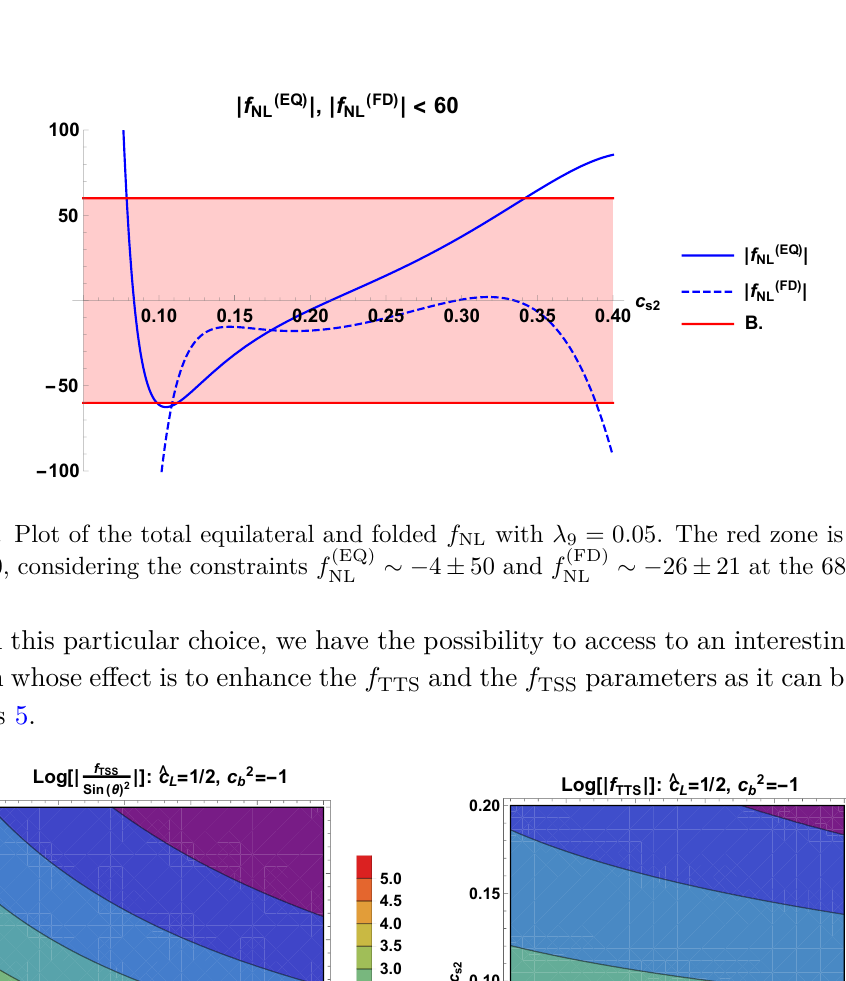
f NL -like parameter with sin( θ ) 2 set to one and λ 9 = 0 . 05 . π 0 -like parameter with (cid:15) set to 1, and k π 0 f NL